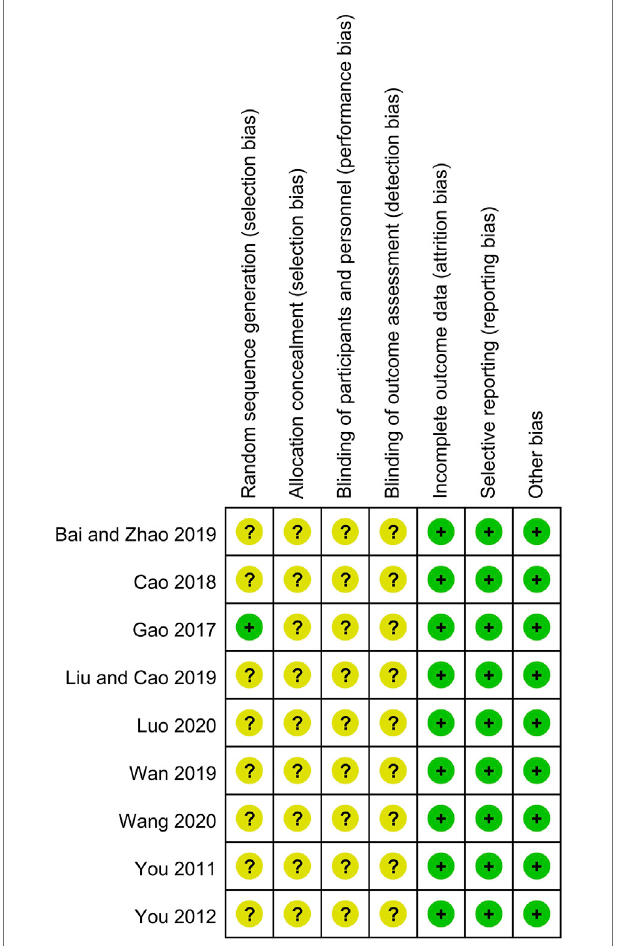
FIGURE 2 | Summary of risk of bias assessment.